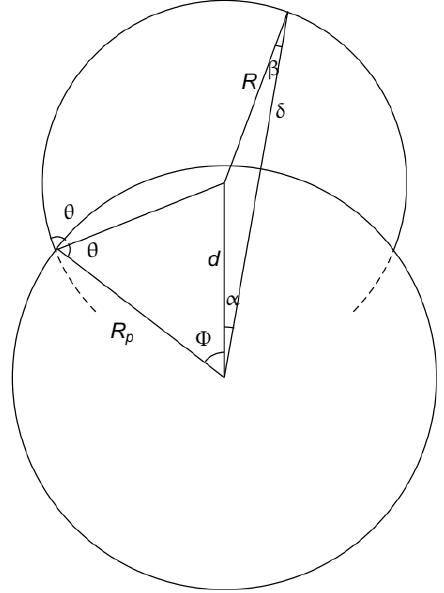
Figure 2. The geometry used in deriving equations for the nucle- ation of a spherical drop on a spherical